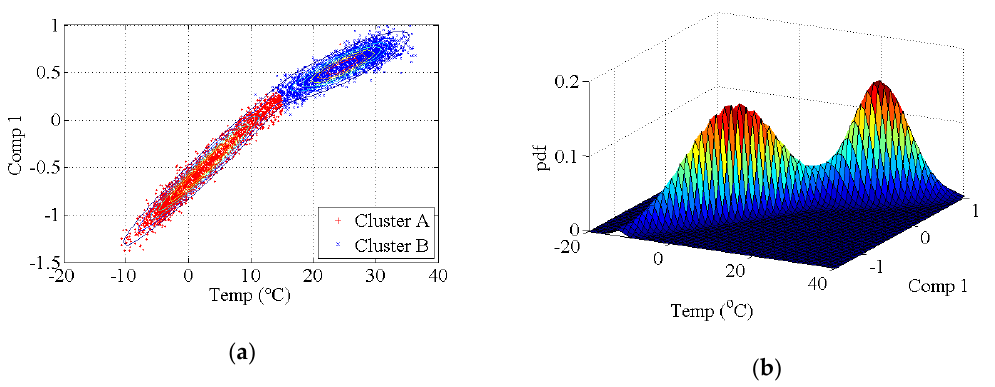
Figure 9. Results of principal component classification by using the GMM. ( a ) two-dimensional results, ( b ) three-dimensional results. Table 1. Descriptions of all cases for the numerical example .